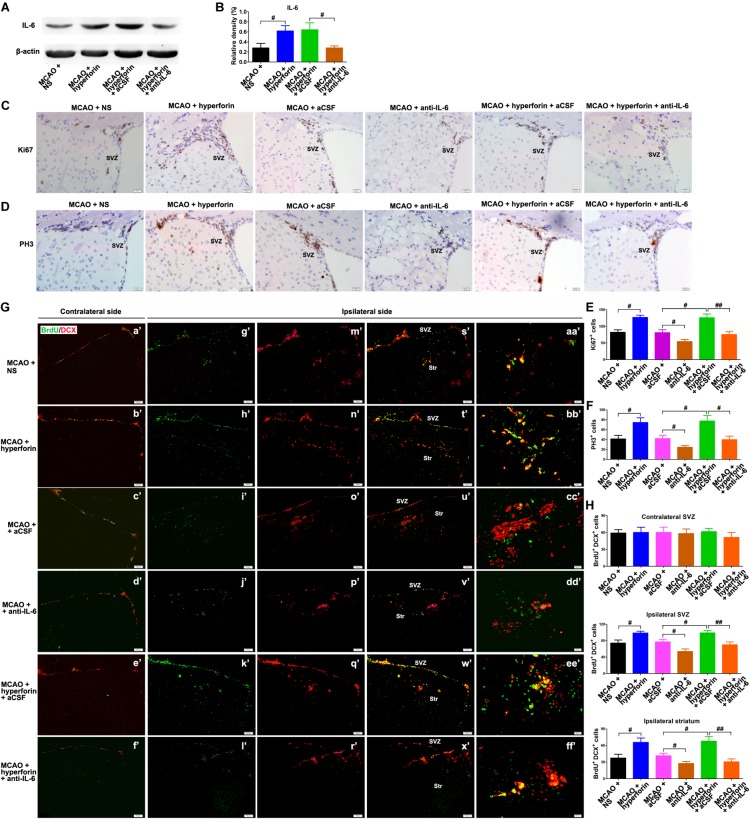
Hyperforin promoted subventricular zone (SVZ) neurogenesis via IL-6 after ischemic stroke. Western blotting images (A) and quantitative data (B) for IL-6 in the ischemic hemisphere of each group at 28 dpi. Data represent mean ± SD, n = 5; #P < 0.05. Representative micrographs and quantitative determination of Ki67 (C,E) and phospho-histone H3 (PH3)-labeling cells (D,F) for each group in the ischemic SVZ at 28 dpi. Bar = 20 μm. Data represent mean ± SD, n = 5; #P < 0.05; ##P < 0.01. (G,H) Immunofluorescence imaging and quantitative comparison of BrdU+ (red) cells coexpressing doublecortin (DCX) (green) for each group in the ischemic SVZ and striatum at 28 dpi. Bar = a′–x′ = 100 μm, aa′–ff′ = 20 μm. Data represent mean ± SD, n = 5; #P < 0.05 and ##P < 0.01. aCSF, artificial cerebrospinal fluid.